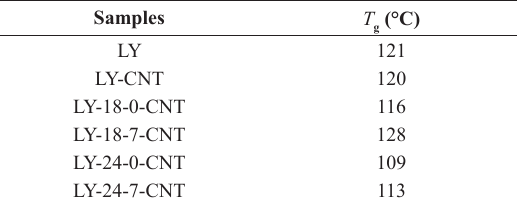
Table 2. Glass transition temperatures values obtained by